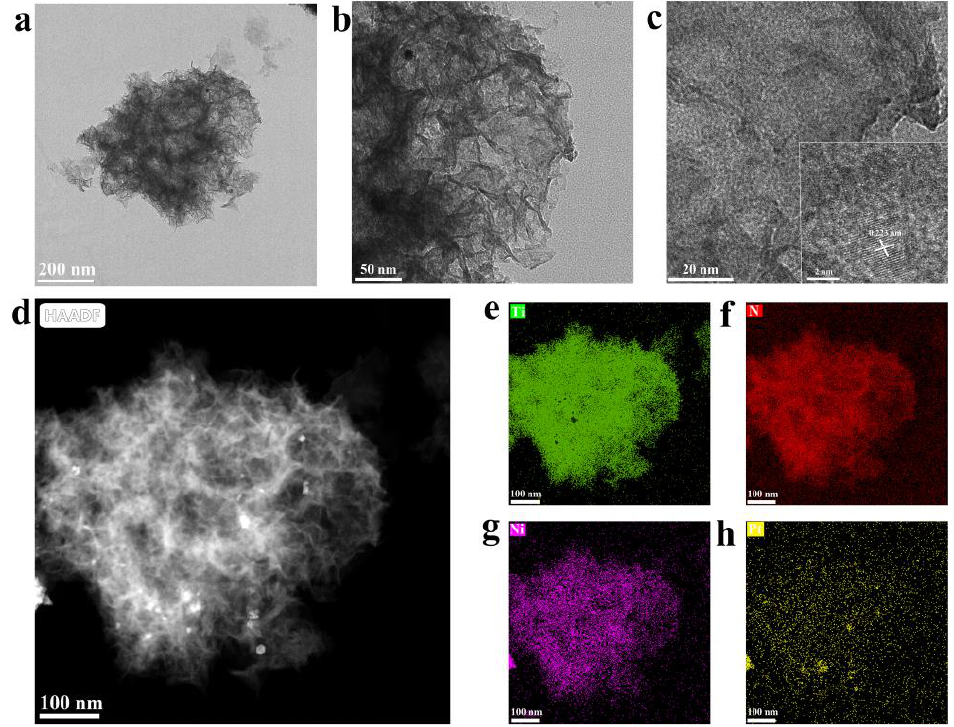
Figure 3. TEM images of ( a , b ) PtNi/PTOC catalyst; ( c ) HRTEM; ( d ) HADDF-STEM ( e – h ); EDX images of PtNi/PTOC.